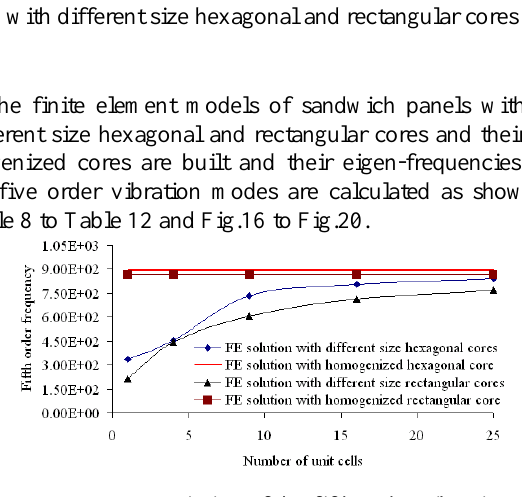
Frequency variation of the fifth order vibratioFig.20. n